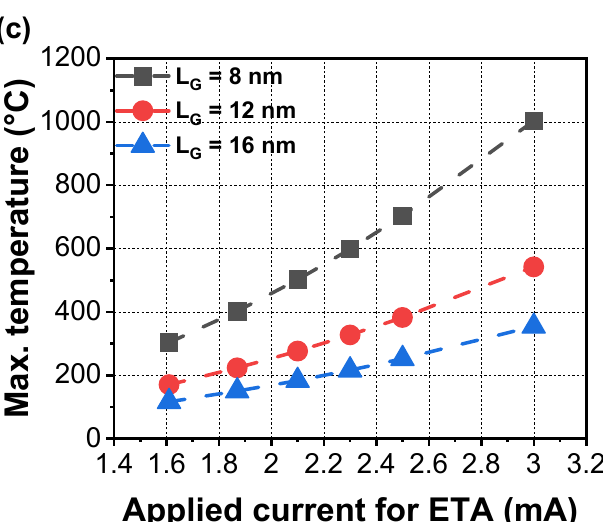
Figure 3. ( a ) Extracted temperature during the ETA in an NS FET with vacuum dielectric with respect to L G . Extracted ( b ) gate to-gate resistance and ( c ) maximum temperature with various applied currents for the ETA, respectively. Inner spacer thickness (T IN ) was fixed to 3 nm regardless of L G .